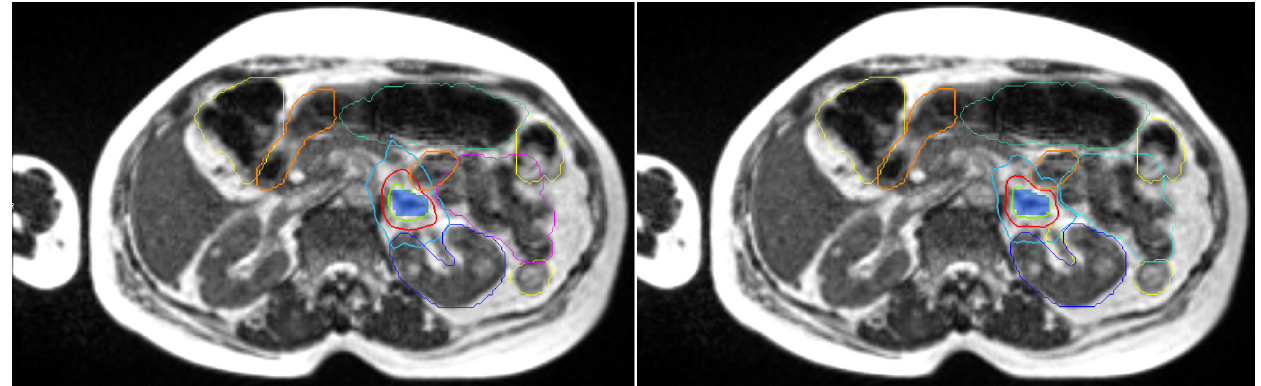
Differences are statistically significant in case of p -value < 0.05 (value in bold).